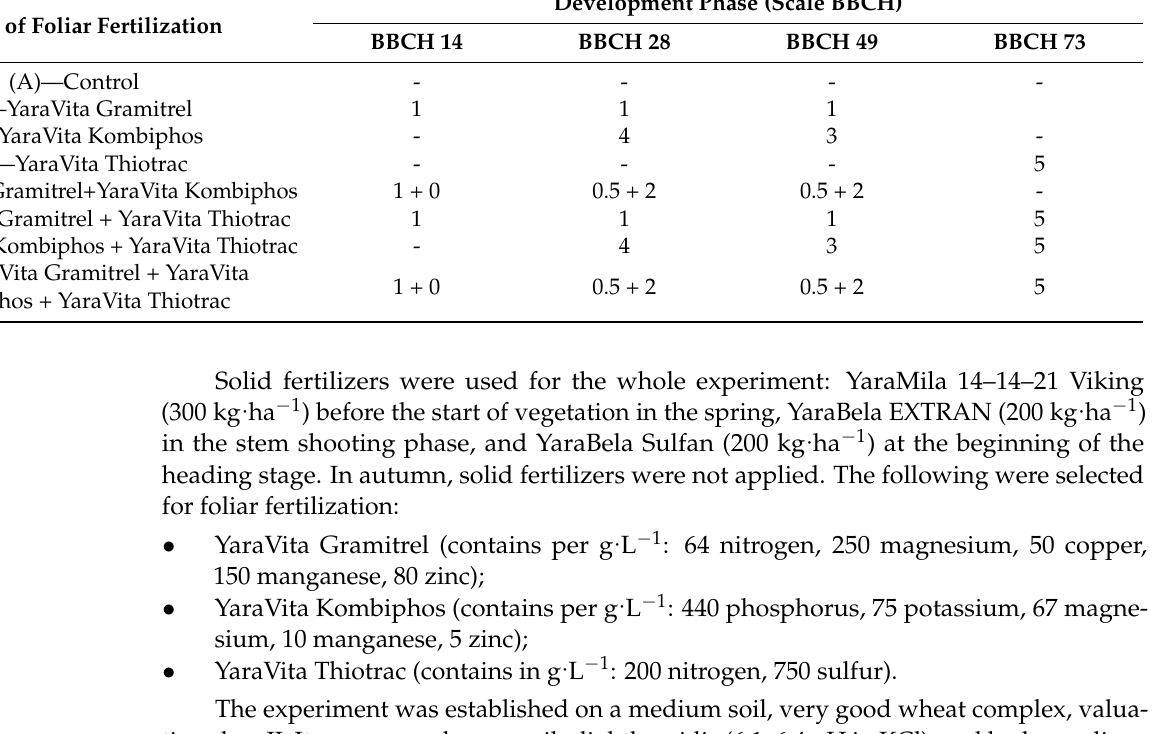
Table 1. Scheme of diversified fertilization of winter wheat (L·ha −1 ). Variant of Foliar Fertilization